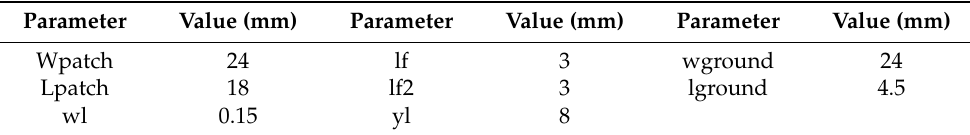
Table 7. Optimized parameter values of the proposed antenna.